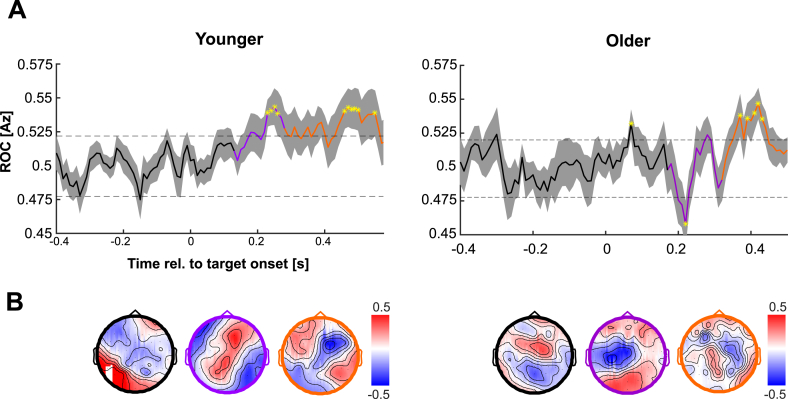
Task-relevant EEG components. (A) A linear classifier based on EEG data in 80 ms windows was used to discriminate between the two frequency conditions of interest. The smooth curve reflects group-averaged ROC values (Az) with SEM represented by shaded boundaries. Yellow asterisks highlight projections in which Az reached significance, and the dashed lines represents significance, based on randomisation tests (at p < 0.001). Coloured curve segments indicate the k-means clustering of scalp projections derived from the classifier topographies. Clustering revealed three distinct components, each systematically different temporally and topographically. The first cluster (black curve) spanned the epoch in which the stimulus was being presented; the second (purple) cluster comprises shorter-latency activity possibly originating from sensory-specific regions; and the third (orange) cluster reflects later-activated.